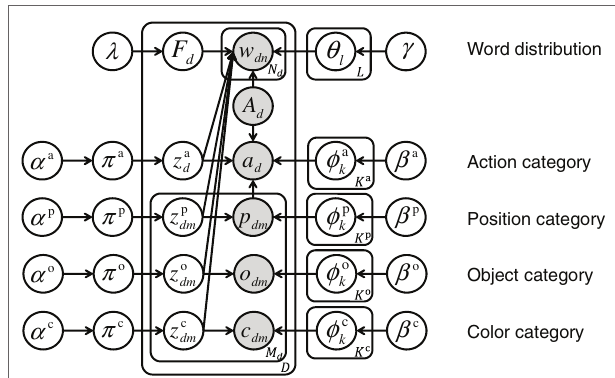
FIGURE 2 | Proposed graphical model for multichannel categorizations and for learning word meaning; the action, position, color, and object categories are represented by a component in Gaussian mixture models (GMMs). A word distribution is related to a category on GMMs. Gray nodes represent observed variables. Each variable is explained in the description of the generative model in Section